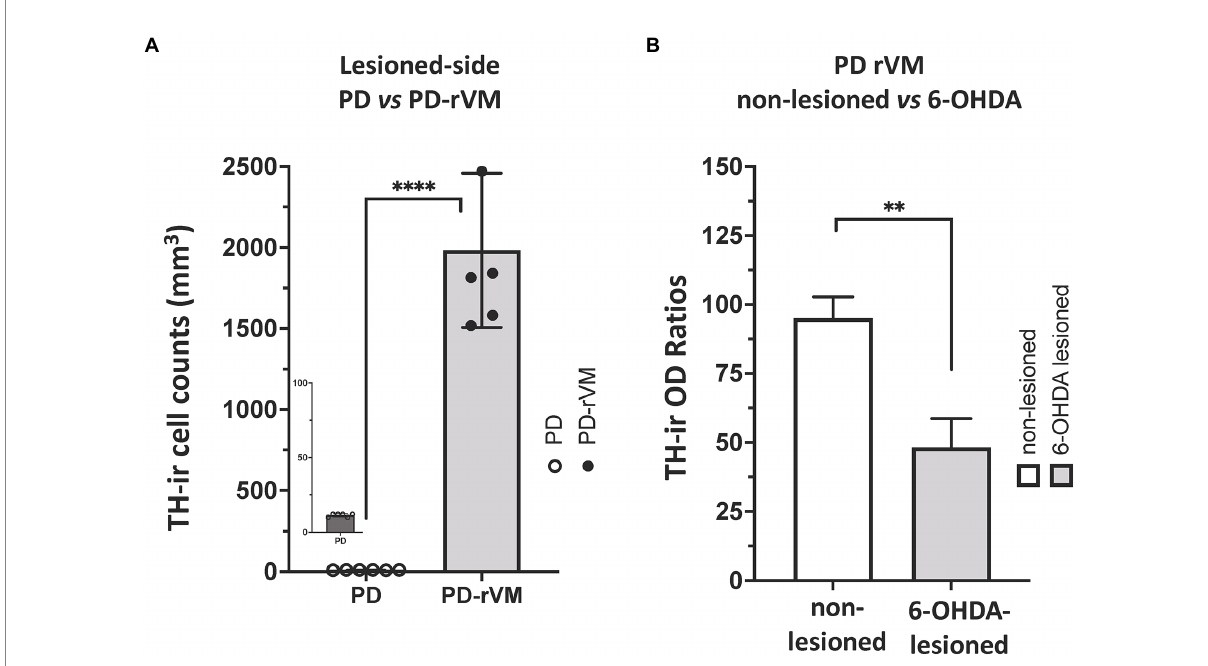
FIGURE 8 Quantitative immunohistochemical analysis of TH immunoreactivity in the striatum of PD rats. (A) The number of TH-positive cells was much higher in the lesioned striata of the PD rats receiving cell transplantation (PD-rVM). (B) In PD-rVM group, at 4 weeks after cell transplantation, TH-ir OD ratios reached to 47% when normalized to unlesioned side (100%). ** p < 0.01, ** ** p <